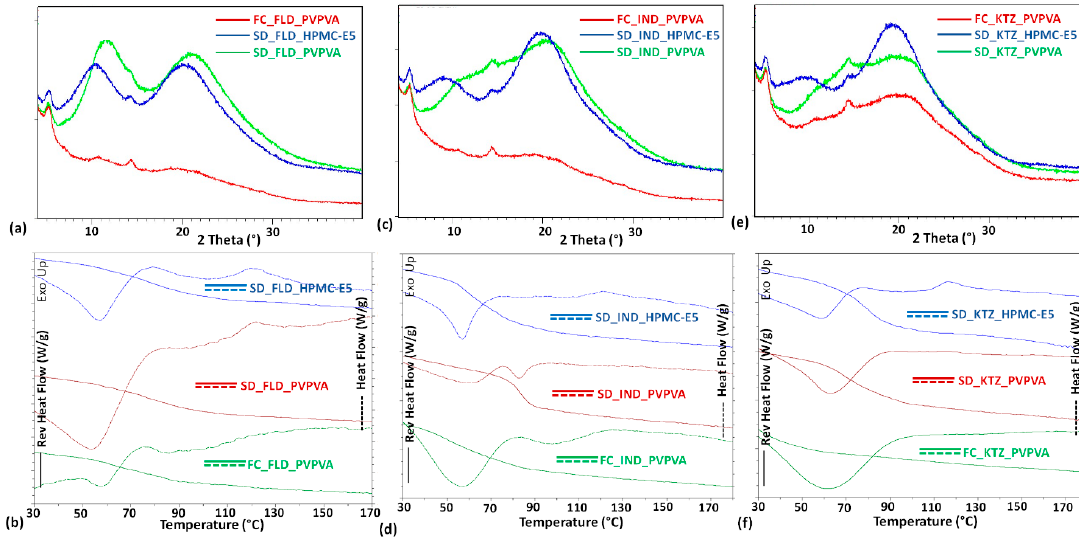
Figure 3. Overlay of PXRD patterns and mDSC thermograms of different ASDs samples of ( a )–( b ) Felodipine, ( c )–( d ) Indomethacin, and ( e )–( f ) Ketoconazole.